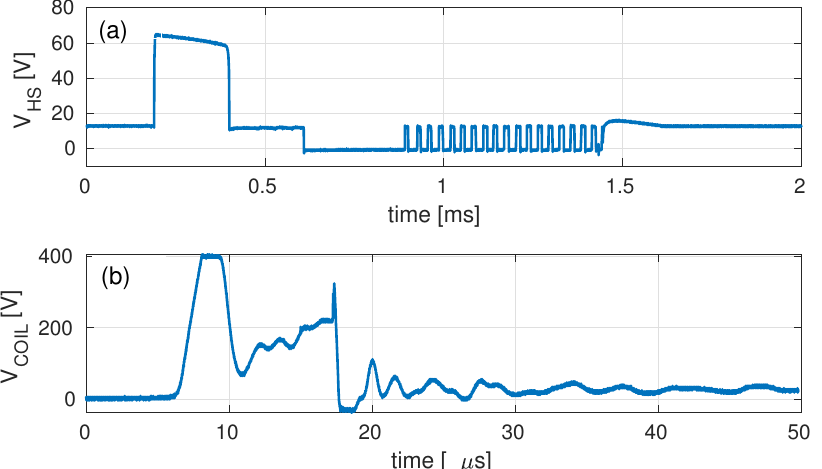
Figure 2. ( a ): Measured voltage waveform at the high-side of a GDI-engine injector. ( b ): Measured voltage waveform at the input of the ignition coil.